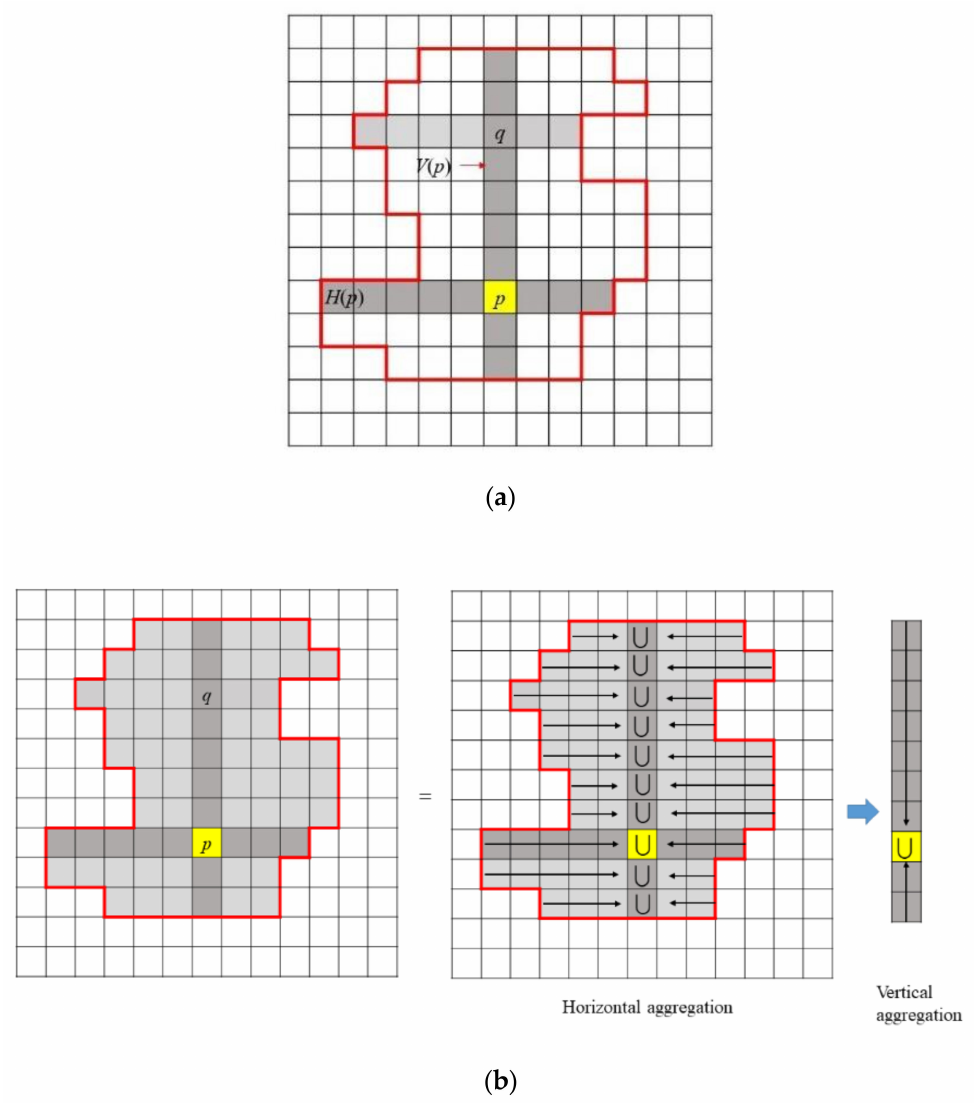
Figure 1. Profile of cross support region for pixel p : ( a ) Cross construction; ( b ) Cost aggregation. Each pixel p consists of a horizontal section H ( p ) and vertical section V ( p ) . q ∈ V ( p ) is a pixel that belongs to the vertical section. Each section has two arms, e.g., H ( p ) consists of left and right arms. “U” is union